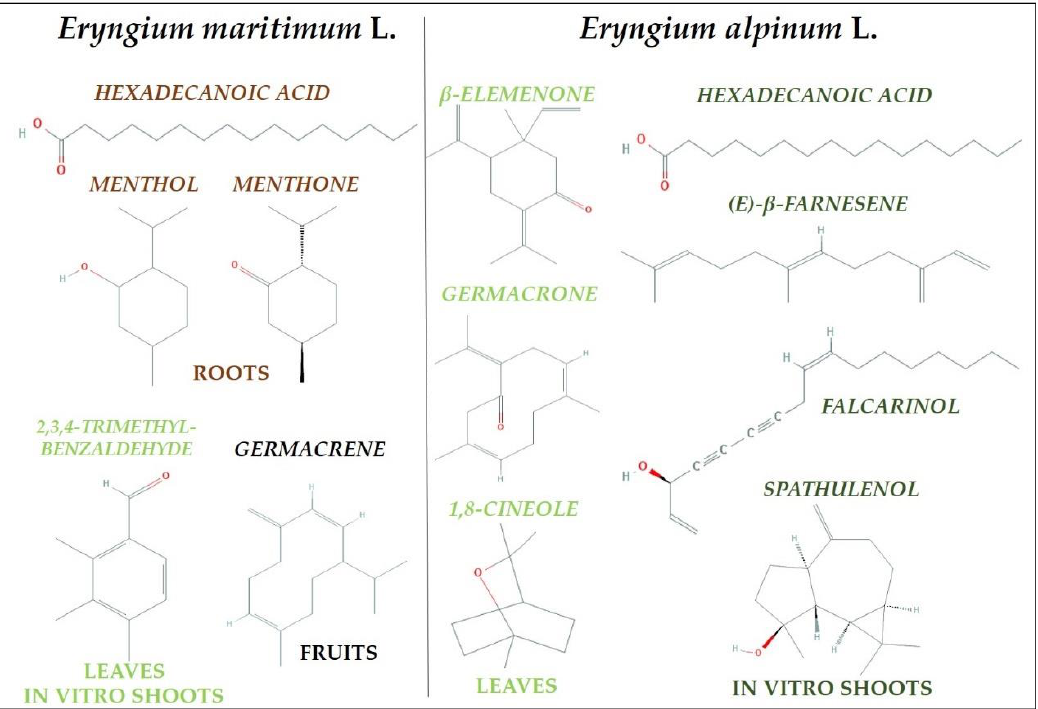
Figure 1. The main compounds of the essential oil from different organs of the intact plants and in vitro shoot cultures of E. maritimum and E. alpinum.